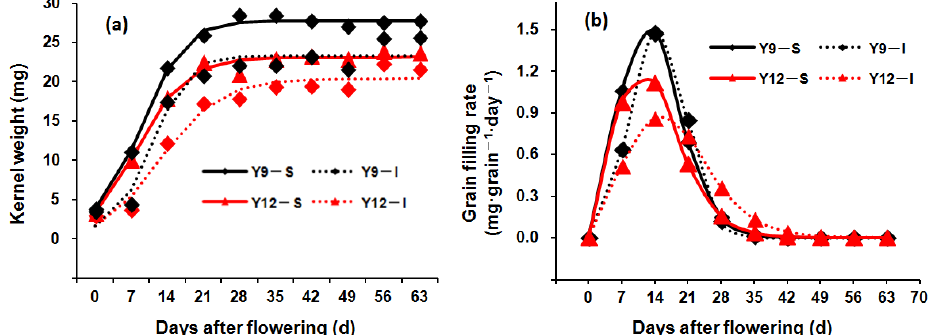
Figure 6. Changes in grain weight and grain-filling rate through time: ( a ) kernel weight; ( b ) grain-filling rate. Y9 and Y12 denote the rice varieties, Yongyou9 and Yongyou12, respectively; S and I indicate superior and inferior grains, respectively.